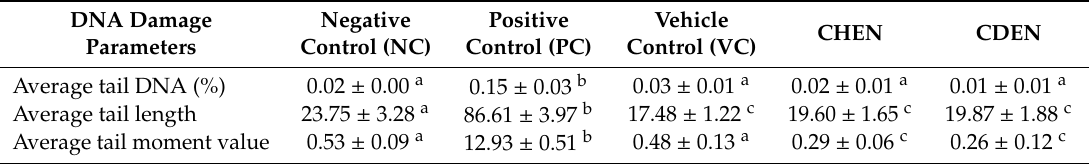
Table 3. DNA damage parameters derived from the alkaline comet assay, where di ff erent superscript letters in the same row (a, b, c) indicate significant di ff erences between means ( p ≤ 0.05) according to Tukey’s test; the values after ± represent the standard deviation of the mean.